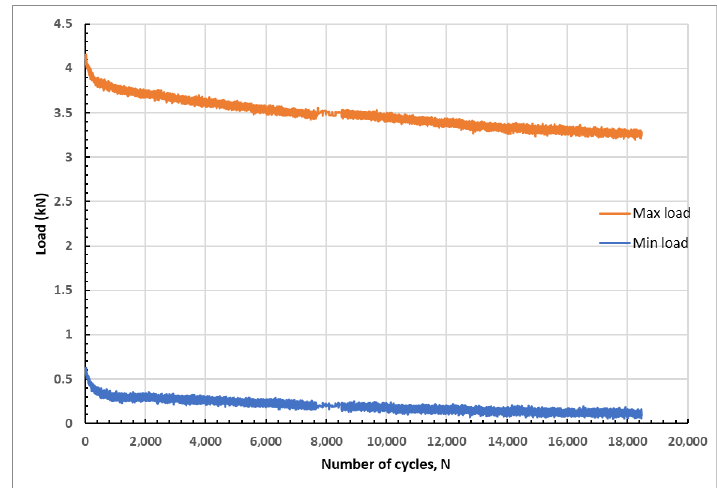
Figure 10. Maximum and minimum load during the fatigue test.